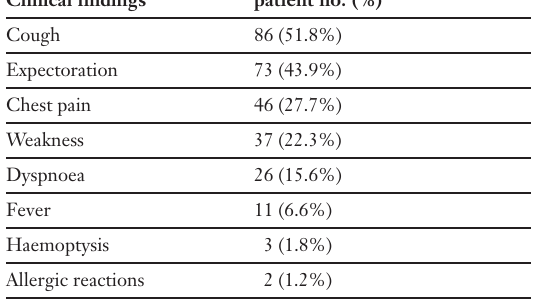
Table 1. Major clinical manifestations in 166 symptomatic